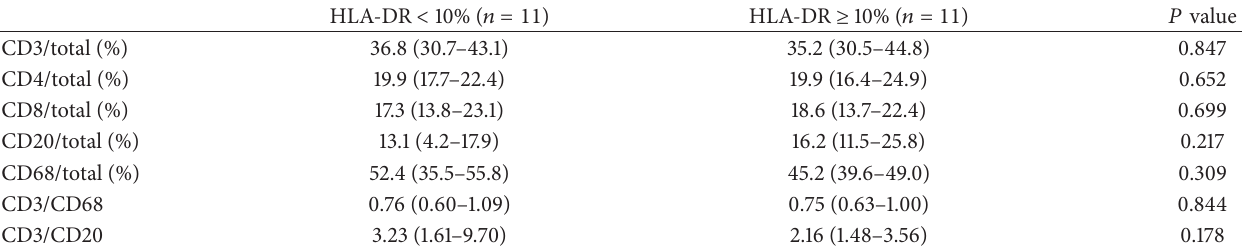
Table 4: Proportions of infiltrating lymphocytes in HLA-DR-positive and HLA-DR-negative BKVN